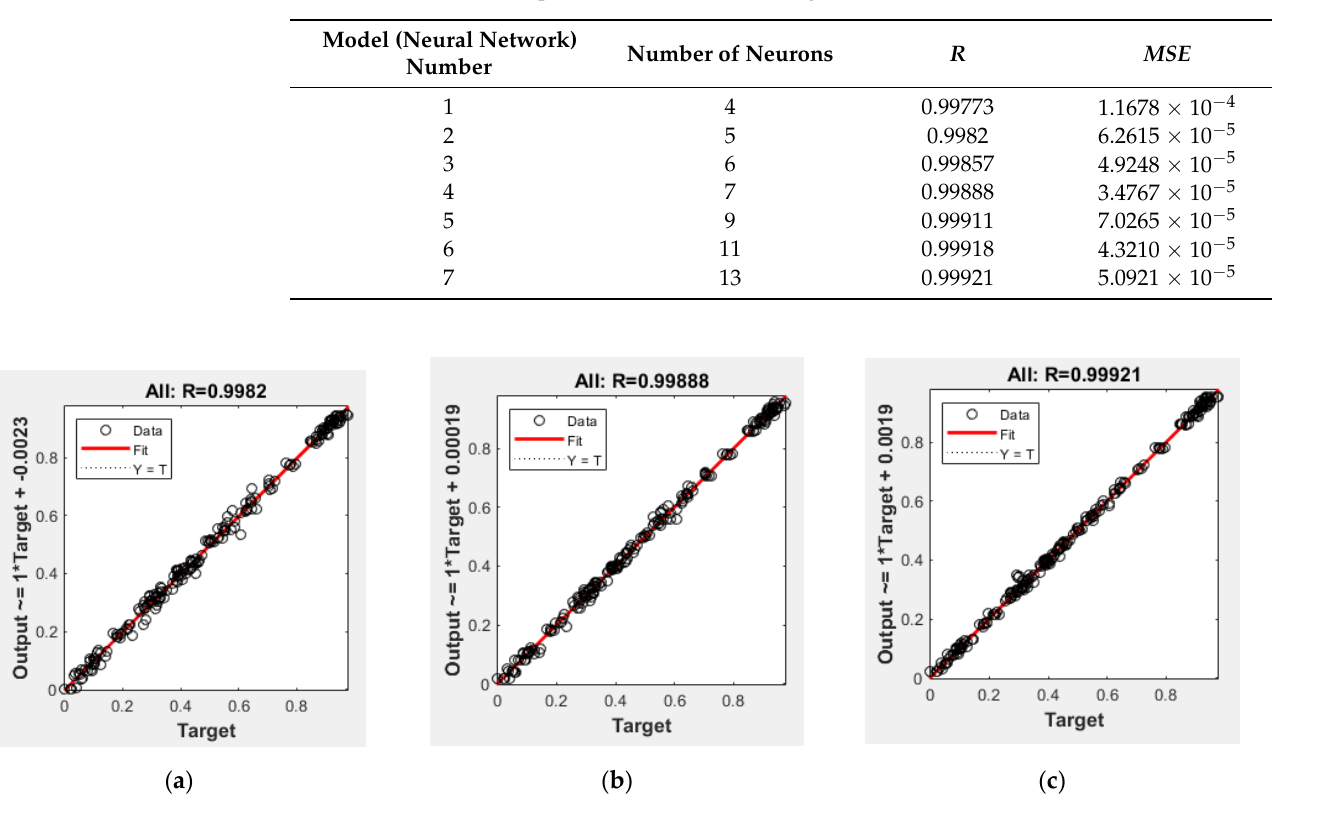
Figure 4. Correlation between the training sample data and the neural network output; neural network No.2 ( a ); No.4 ( b ); No.7 ( c ).